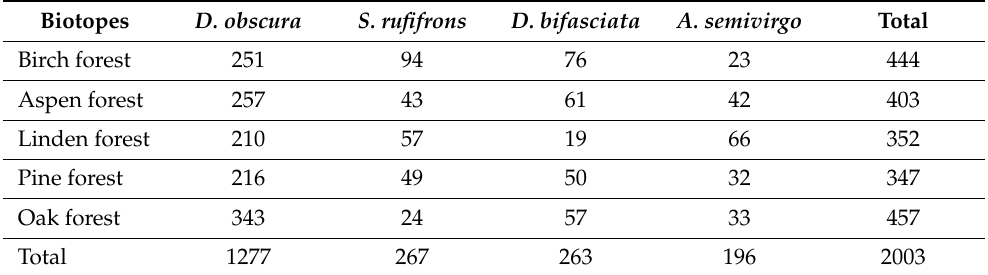
Table 5. Total collected specimens of xylosaprobiont drosophilid species in five biotopes.